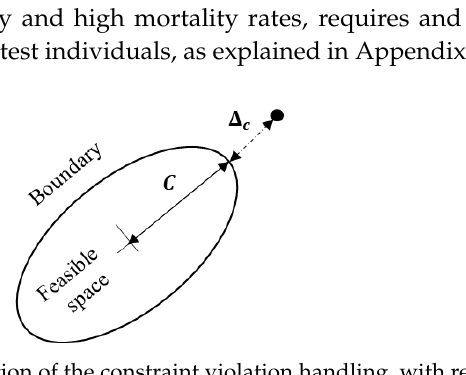
Figure A2. Schematic representation of the constraint violation handling, with reference to